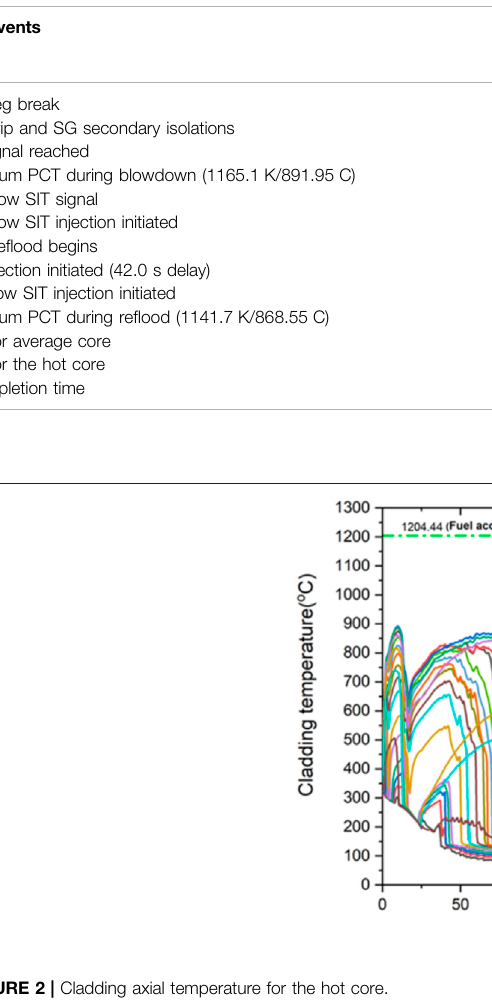
TABLE 7 | Validation of the timing of key LBLOCA events.